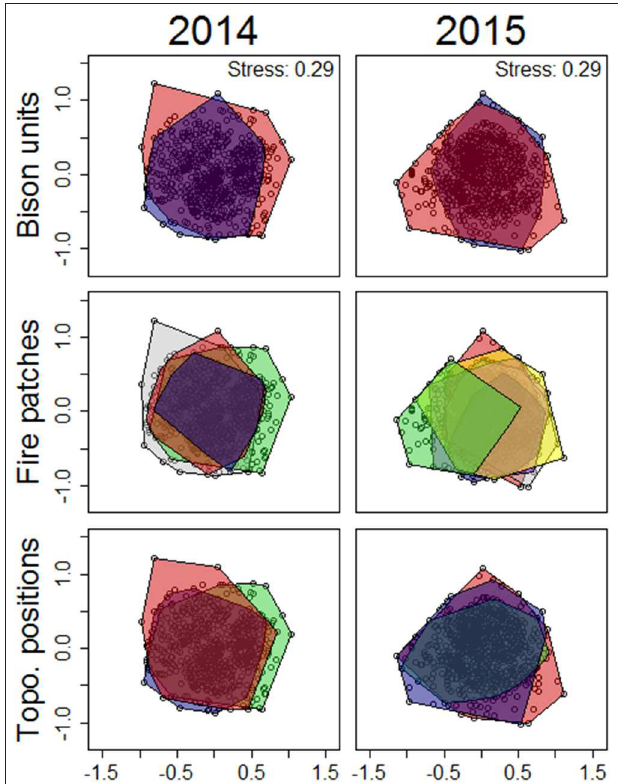
FIGURE 3 | Nonmetric multidimensional scaling (NMDS) ordination of Nebraska Sandhills plant community composition collected in discrete fire patches in August 2014 and 2015. Ordinations were duplicated for each sampling period with color envelopes corresponding to functional patch types. Color envelopes for bison units are red for the west bison unit and blue for the east bison unit. Color envelopes for fire patches are red for the 2012 wildfire, blue for the 2012 prescribed fire, green for the 2013 prescribed fire, purple for the 2014 prescribed fire, yellow for the 2015 prescribed fire, and gray for the area unburned between 2012 and the end of the study. Color envelopes for topographic positions are red for north dunes, blue for south dunes, and green for interdunes. Stress values are included to show how well the ordination summarizes the observed distances among samples (stress > 0.3 is a poor representation, 0.2–0.29 is acceptable, 0.1–0.19 is great, and < 0.1 is excellent). The distance between points corresponds to the difference between samples with overlapping samples indicating no difference between